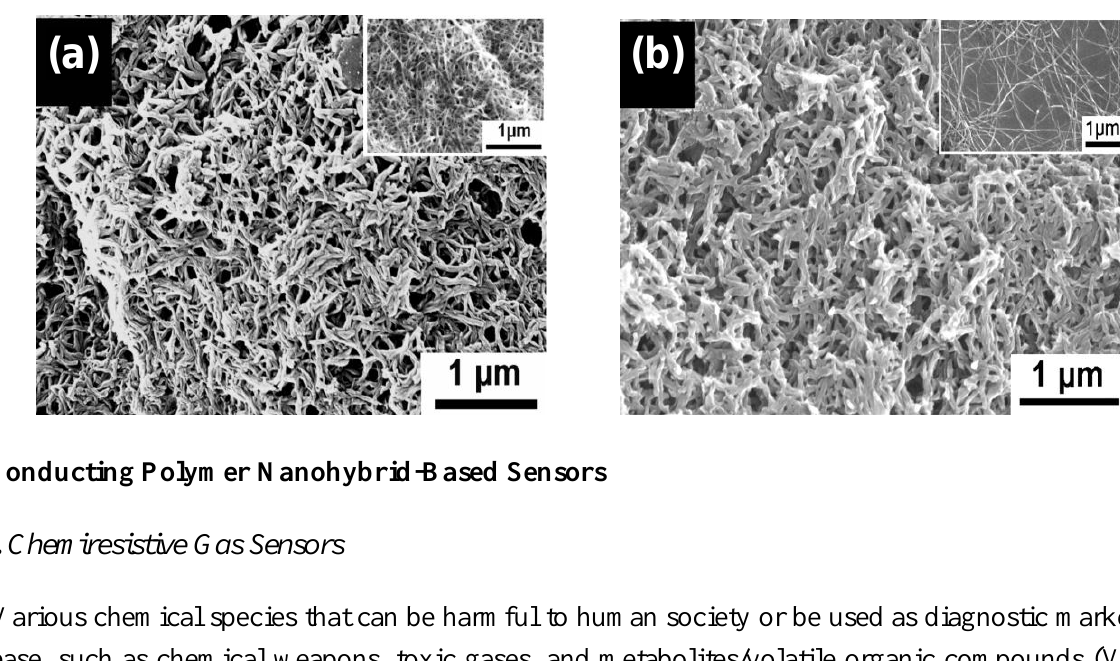
O nanofibers. Adapted with permission 2 5